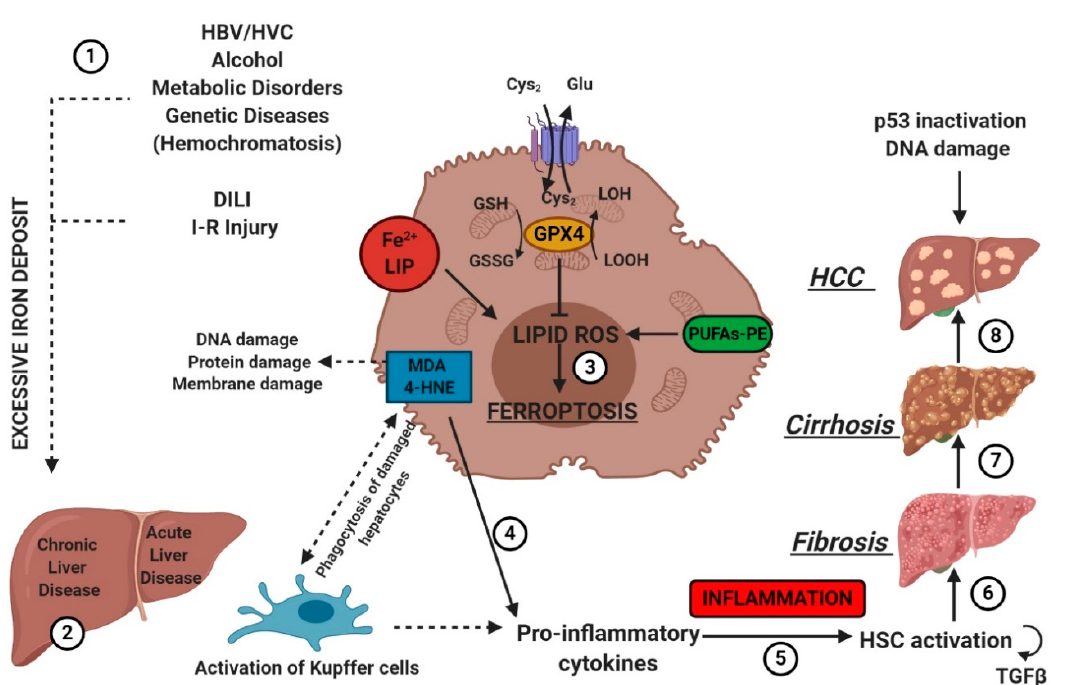
Figure 5. Etiologic factors and the central role of oxidative stress in the development of hepatic diseases. Several factors (e.g., HBV / HCV infection, inadequate alcohol or drug consumption, metabolic or genetic diseases, and I-R injury (1)) may trigger CLD or ALD (2) in the liver, promoting iron accumulation. This supports pro-oxidative state triggering protein and DNA damage and lipid peroxidation (3). The instauration of hepatocyte oxidative stress conditions results in inflammation (4–5), which favors liver fibrosis (6) and cirrhosis (7), and it may lead to hepatocellular carcinoma (8). Numbers (1–8) were added to indicate the path to follow in reading the image. HSC , hematopoietic stem cells; TGF β , transforming growth